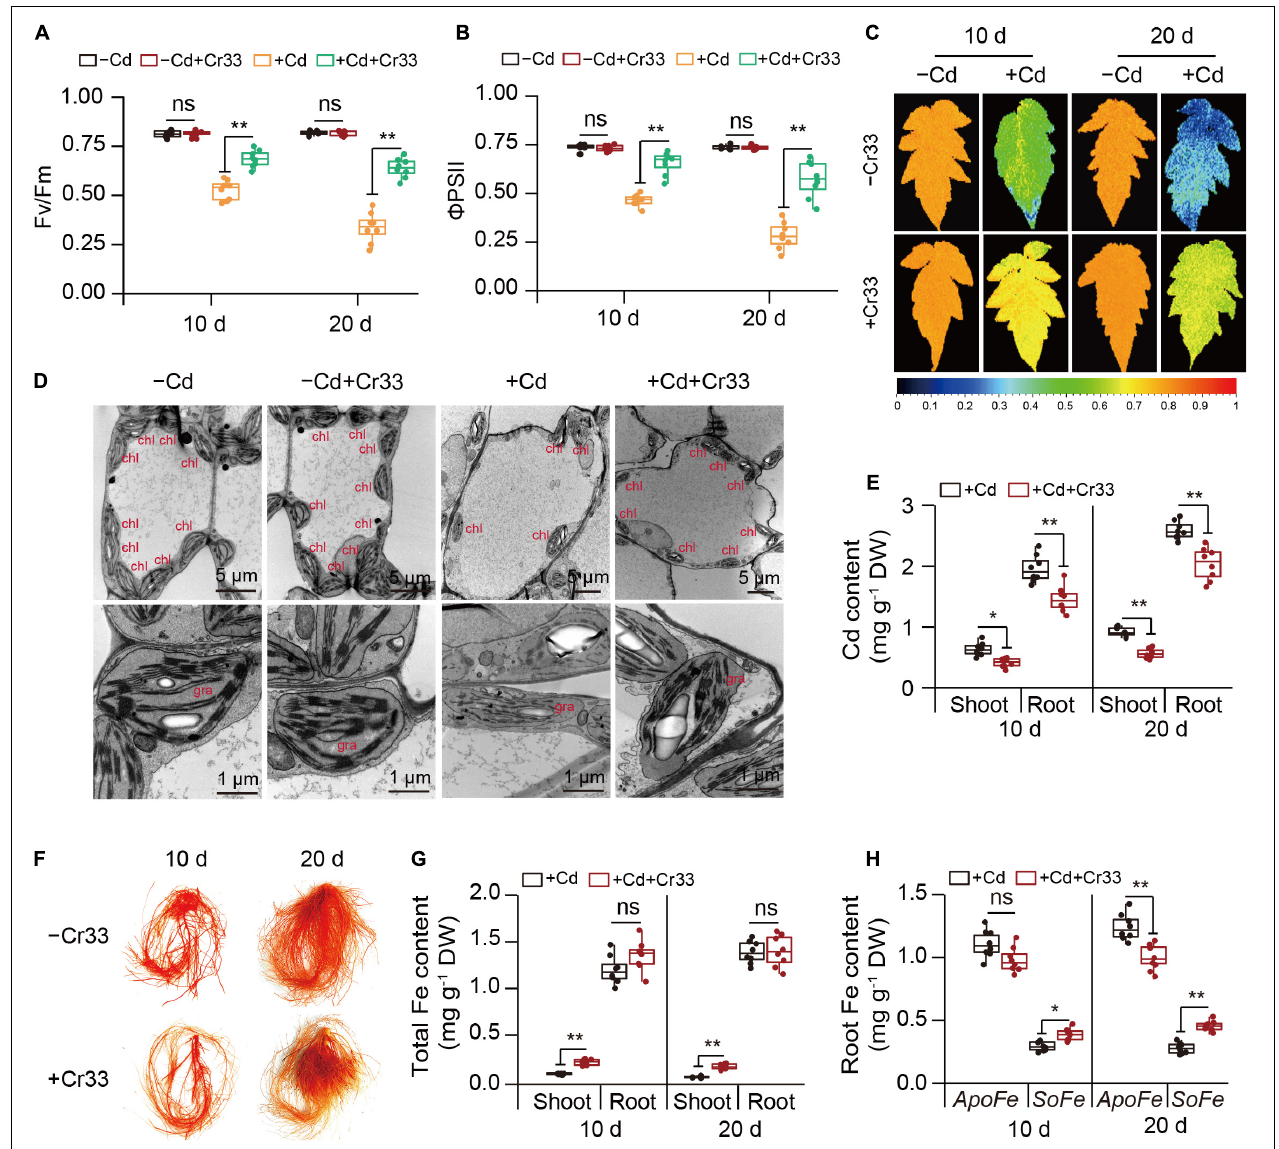
FIGURE 3 | Root inoculation with L. fusiformis Cr33 reduced Cd toxicity in tomato plants. Three-weeks-old tomato plants cultured in the split-root systems were inoculated with or without Cr33 for 3 d. Then, these plants were exposed to 0 or 100 µ M Cd with or without Cr33 for 10 and 20 d, respectively. These plants were used to analyze Fv/Fm (A) , (cid:56) PSII (B) , Fv/Fm images (C) , chloroplast ultrastructure (chl, chloroplast; gra, grana) (D) , shoot and root Cd content (E) , root Cd localization (F) , total Fe content (G) , root apoplastic ( ApoFe ) and soluble Fe ( SoFe ) (H) . Asterisks indicated significant differences between the control and inoculated plants ( n = 8 biological replicates) using Student’s test (ns, not significant; * p < 0.05; ** p <